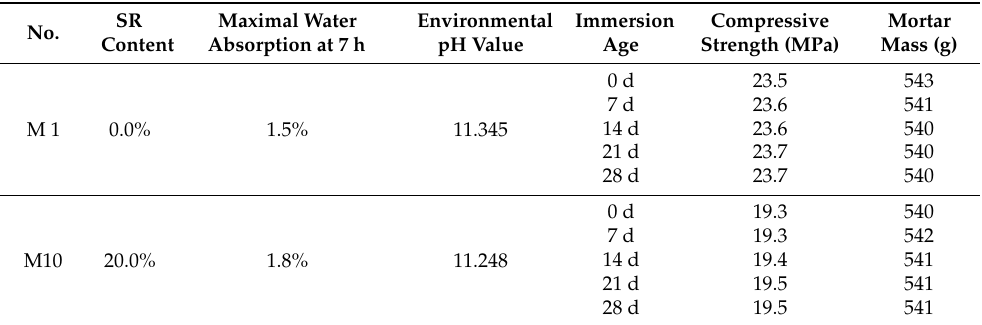
Table 6. The compressive strengths and masses of M1 and M10 (cured for 360 d), under a water environment, for a 28-day immersion age.